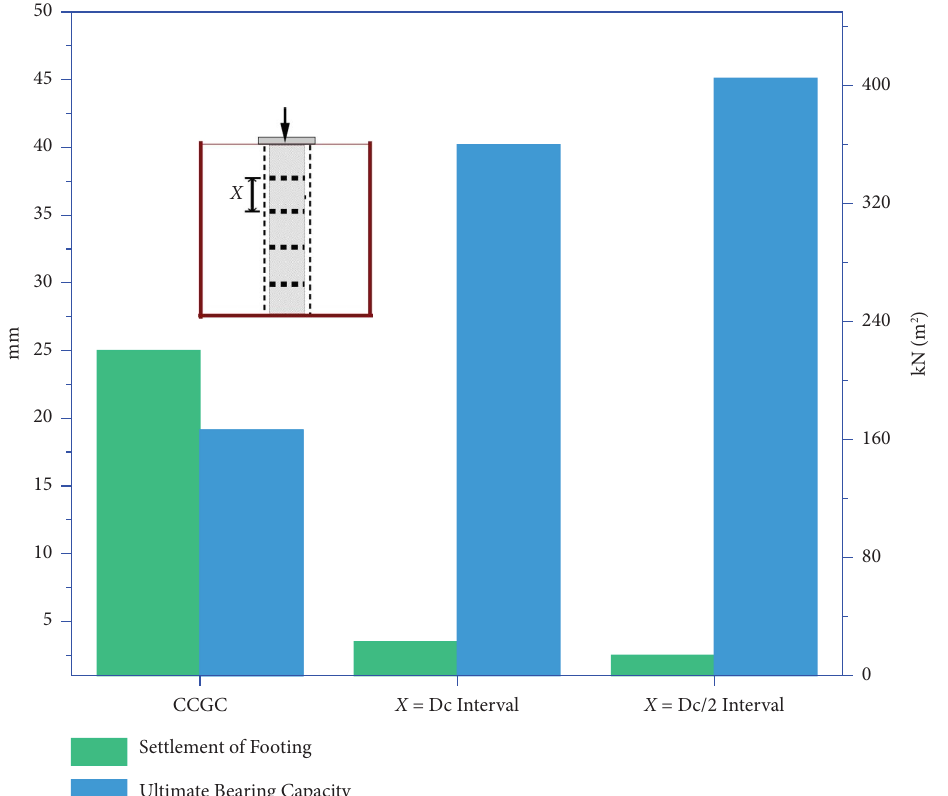
Figure 19: Efect of vertical-horizontal reinforcement on the ultimate bearing capacity-settlement relationship for improved soft